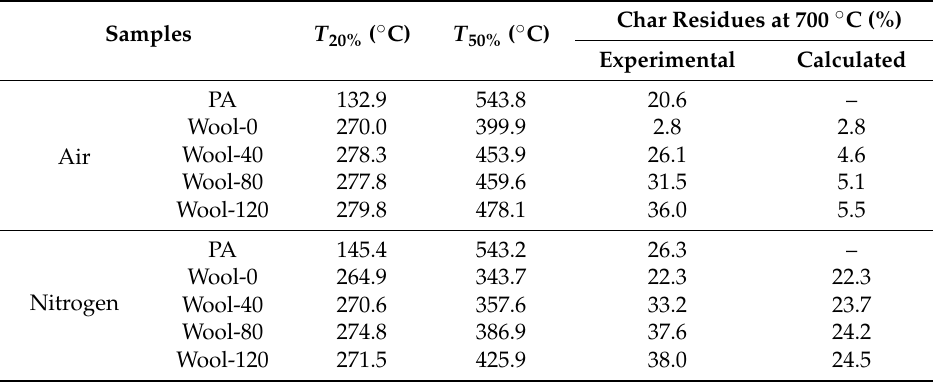
Table 2. TG data of wool fabrics under air and